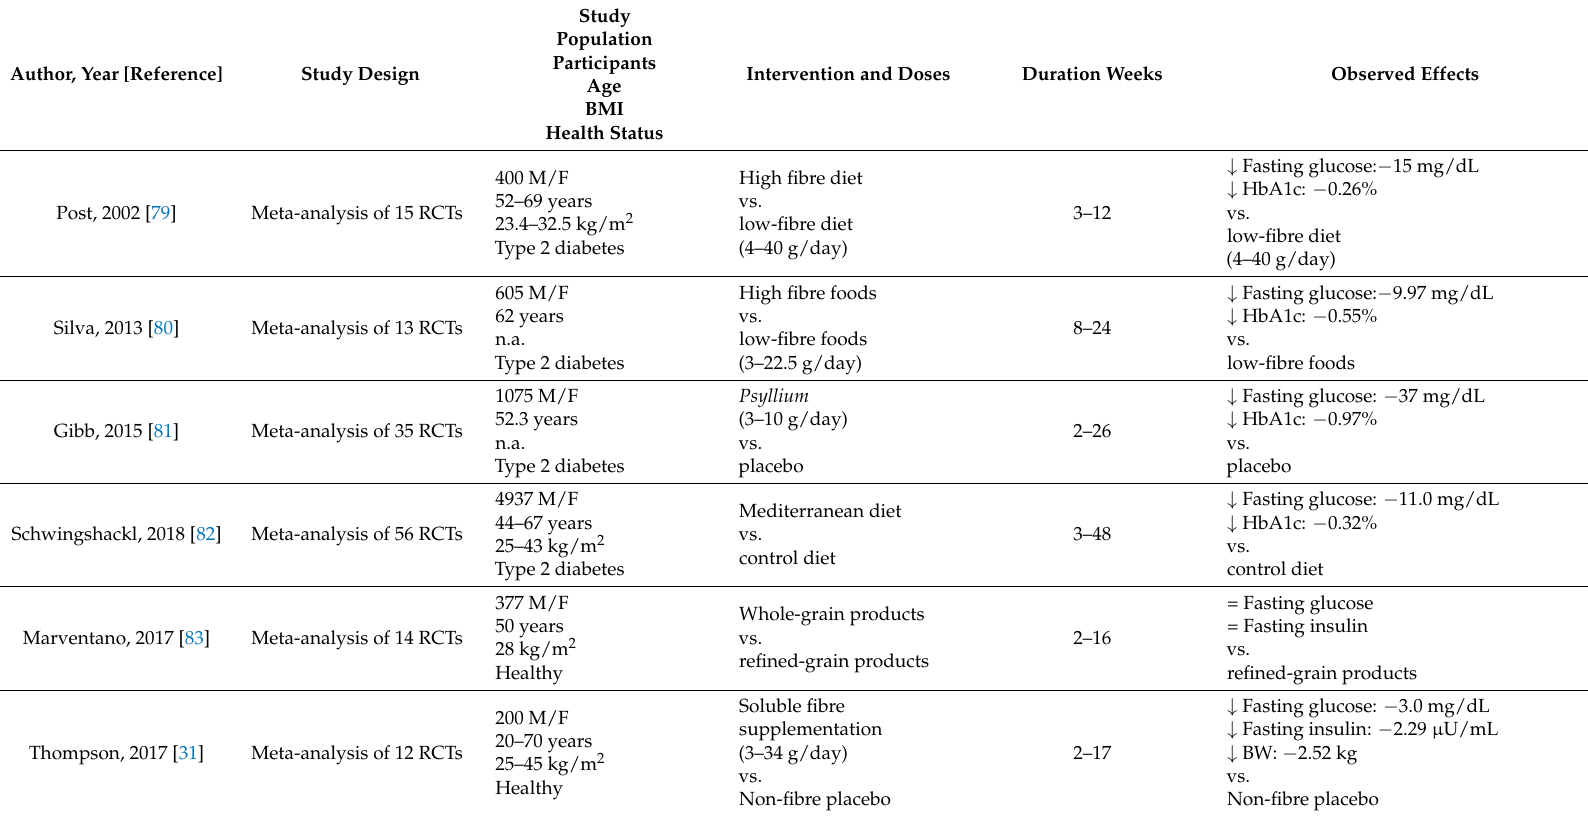
Table 4. Published meta-analyses of RCTs evaluating the effects of different types of fibre on blood glucose